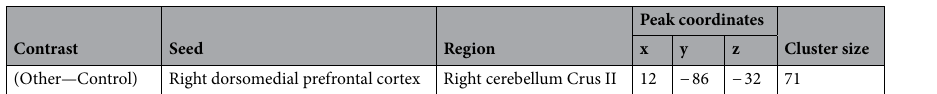
Table 4. between-group connectivity differences. This table shows the significant results of the seed-to-voxel functional connectivity analysis. The selected seed is presented with the corresponding target voxel, its MNI coordinates, and cluster